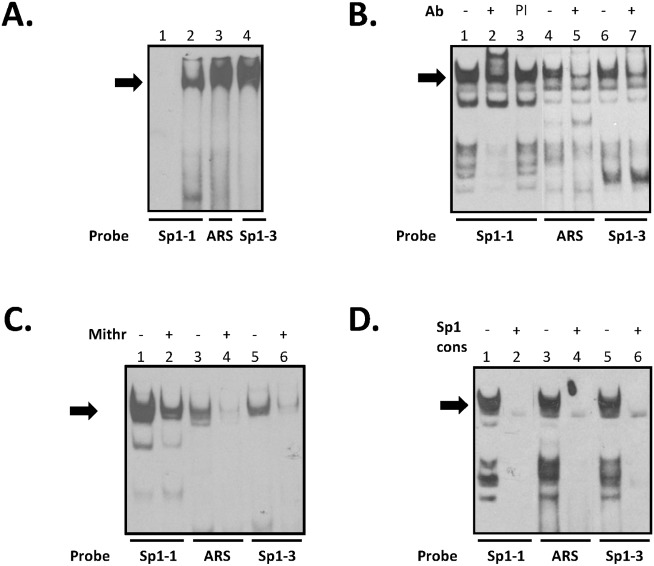
Binding of Sp1 to the AR gene promoter and 5’UTR sequences.Purified Sp1 protein (panel A) or nuclear extract from DU145 cells (panels (B) to (D)) were incubated with the labelled oligonucleotide probes indicated below each gel and the products resolved by electrophoretic mobility shift analysis. Additions are shown above the gels and were: Ab, antibody; PI, pre-immune serum; Mith, mithramycin; Sp1 cons, consensus Sp1 oligonucleotide. Competing unlabelled oligonucleotides (100 fold molar excess) or immune sera were added prior to addition of probe. EMSAs are representative of at least 3 independent experiments. (A) The indicated labelled probes were incubated with purified Sp1 protein except in lane 1 which had no addition. Black arrow indicates Sp1-DNA complex. (B) Anti-Sp1 antibody was added as indicated, and the complex absent after incubation with antibody is indicated by the arrow. (C) Mithramycin (120 nM) was added to indicated lanes and the complex depleted after incubation with the drug is indicated by the solid arrow. (D) Unlabelled competing oligonucleotide encoding Sp1 consensus binding site was added as shown.